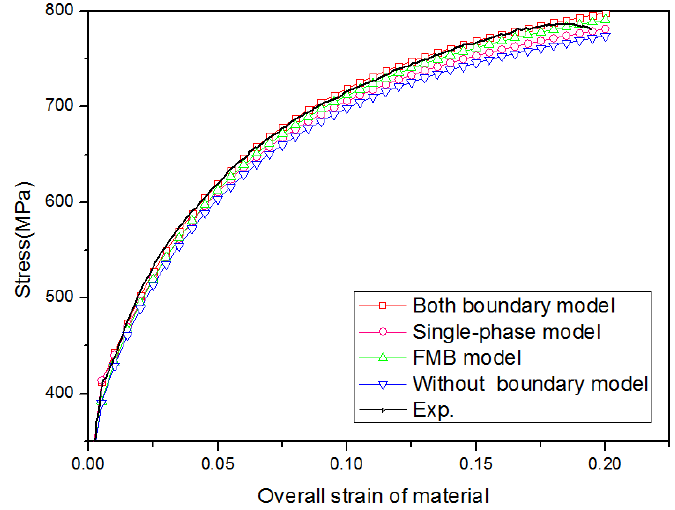
Figure 9. True stress-strain curves of material.